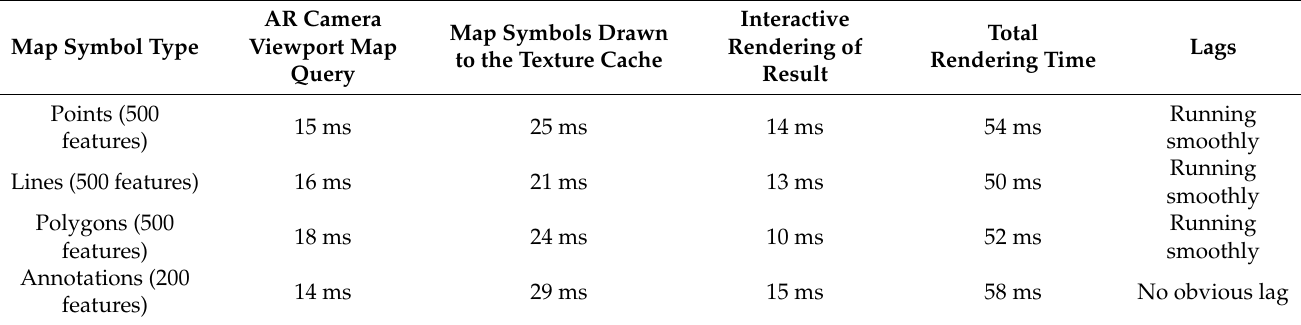
Table 1. Sub process time test of various rendering algorithms.